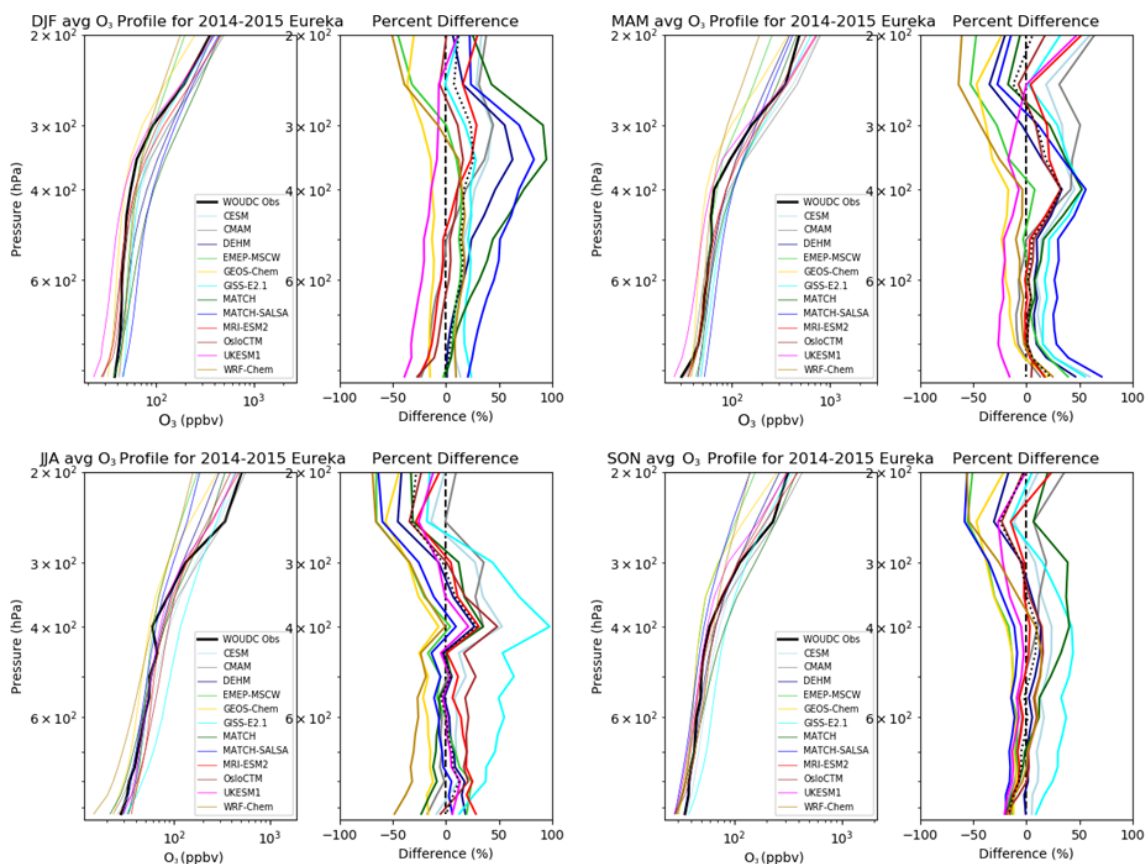
Figure 8. Comparison between observed (thick black line in the left panels) and AMAP models’ (colored lines) O 3 seasonal averages for 2014–2015 at Eureka, NV, Canada. These use monthly mean model output. In each right panel, the dotted black line is the MMM, and the dashed black line shows zero bias for reference. See Fig. S1 for the rest of the ozonesonde locations and a sample comparison done with 3-hourly model output (Fig.